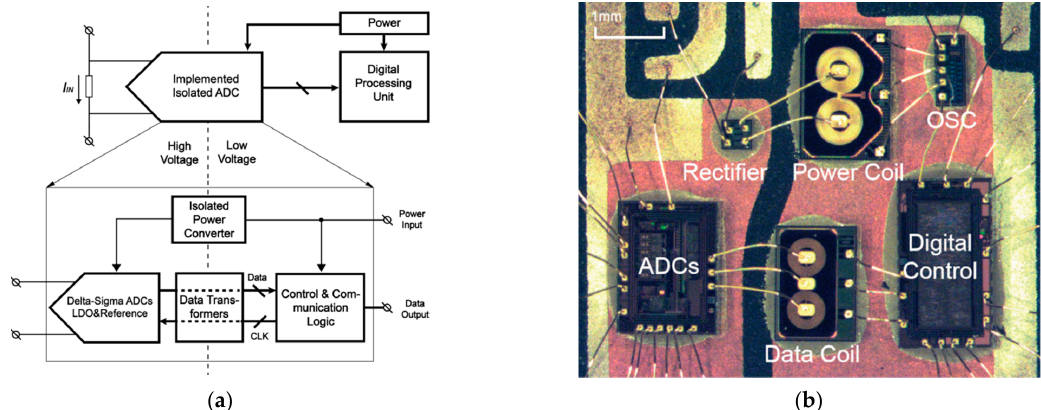
Electronics 2021 , 10 , 2328 Figure 7. Isolated delta–sigma ADC ( a ) Block diagram. ( b ) Micrograph. Reproduced from [20]. Copyright 2016, IEEE.